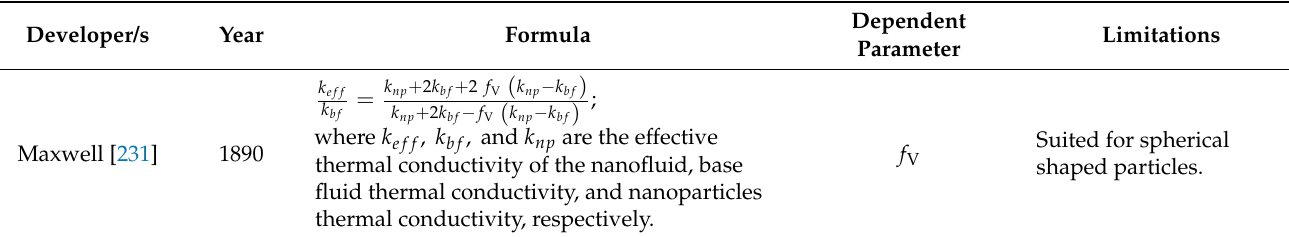
Table 4. Developments of nanofluids effective thermal conductivity formulas.